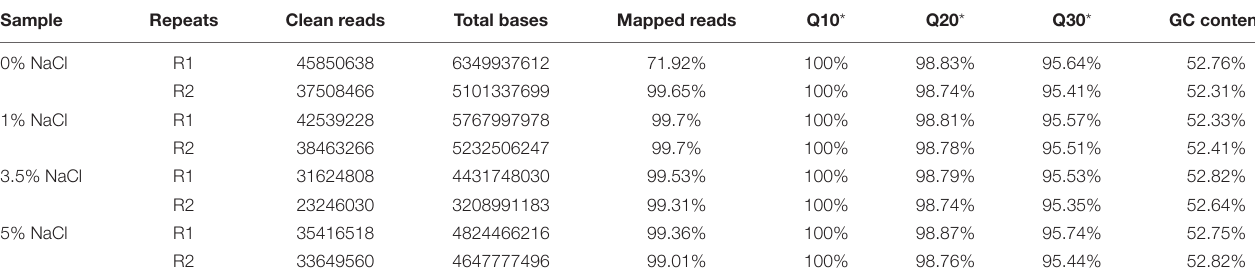
TABLE 1 | RNA sequencing data for the eight samples in the four E. coli groups cultured in different NaCl concentrations. Sample Repeats Clean reads Total bases Mapped reads Q10 * Q20 * Q30 * GC content 0% NaCl